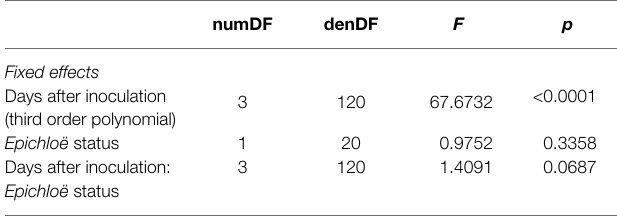
TABLE 2 | Epichloë -inoculated populations tended to have greater disease prevalence tracked over time in a linear mixed model, though this difference had weak statistical support.